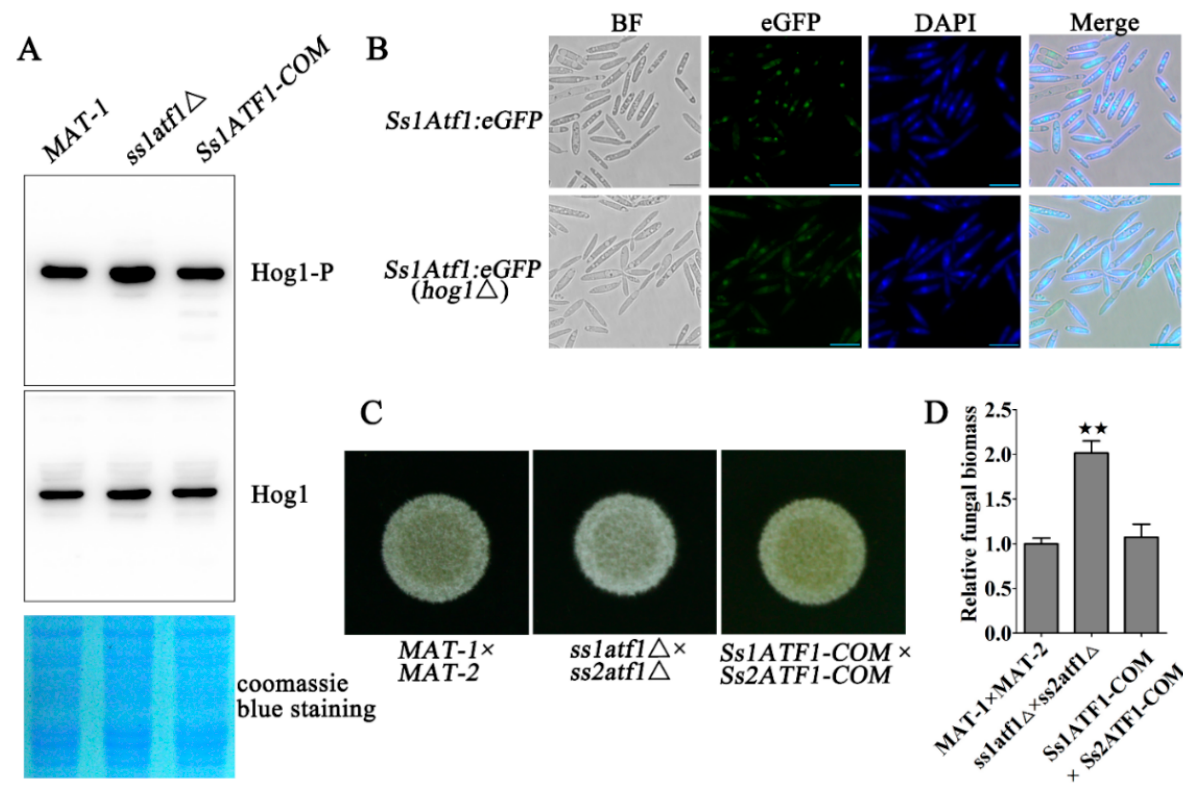
Figure 5. Effect of SsAtf1 on SsHog1 phosphorylation and S. scitamineum mating. ( A ) Phosphorylation of SsHog1 was increased in ss1atf1 Δ mutant cells. The fresh haploid sporidia were grown in